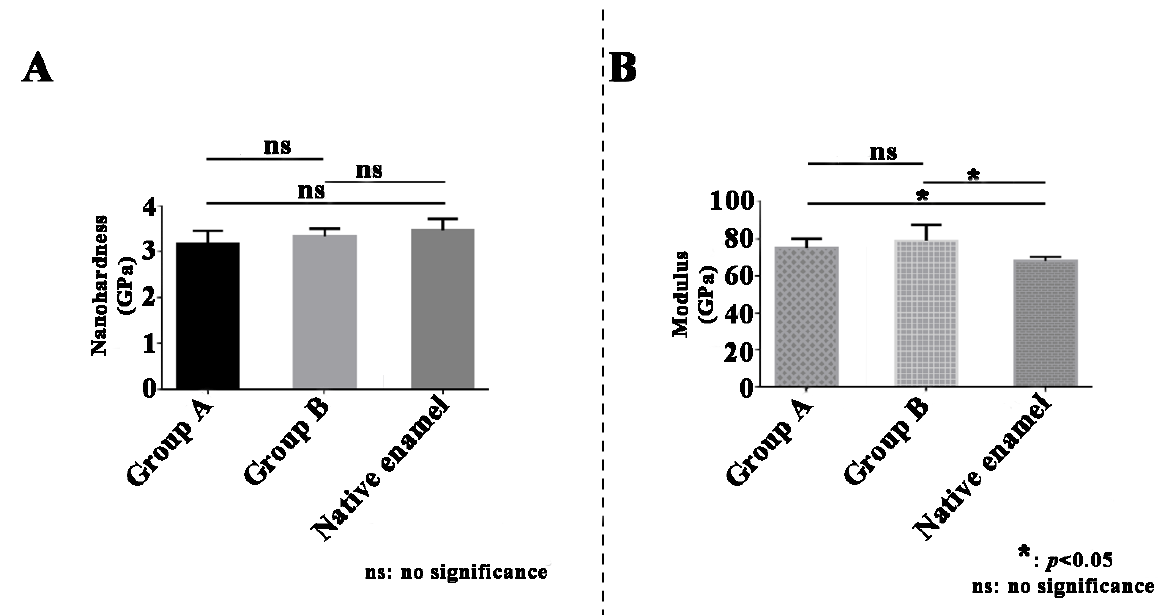
Figure 7. Mechanical evaluation of the synthesized materials. ( A ) Nanohardness of synthesized ma- terials with 0.2 wt% graphene oxide (GO; Group A), with 0.4 wt% GO (Group B), and native enamel. ( B ) Elastic modulus of synthesized materials with 0.2 wt% GO (Group A), with 0.4 wt% GO (Group B), and native enamel.